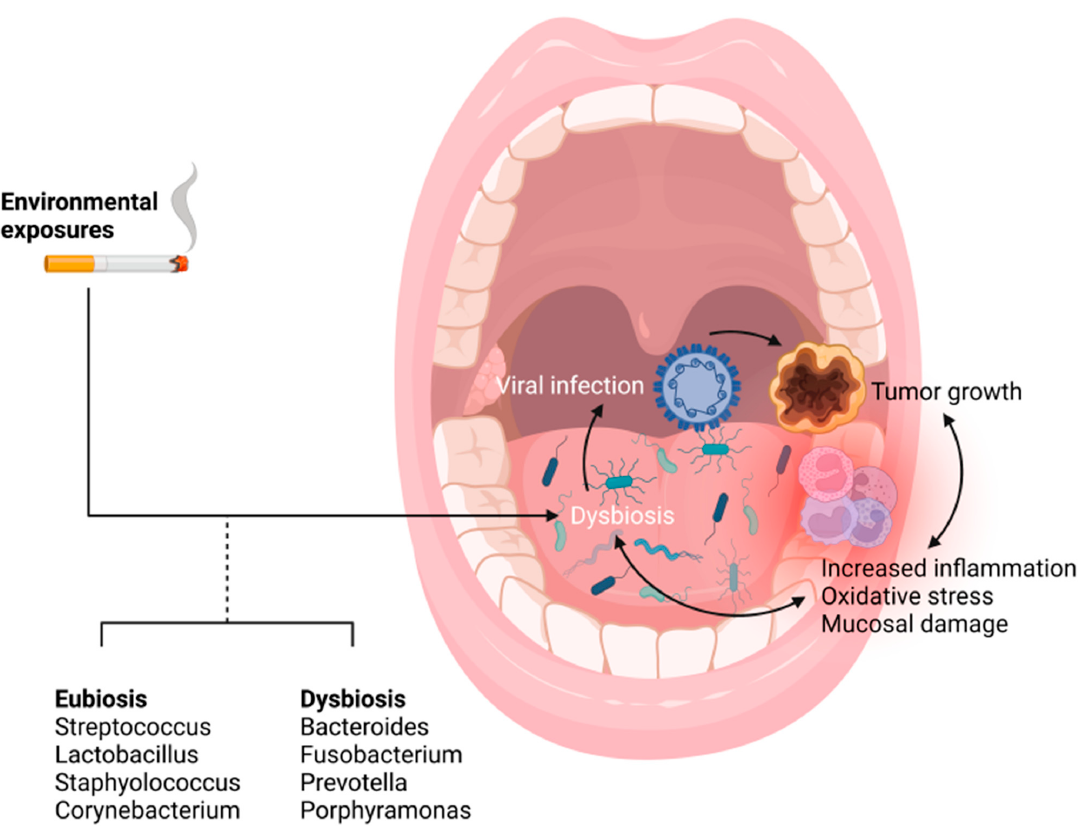
Figure 1. Overview of environment-host-microbiome-tumor interactions. Schematic overview of the interplay between the environment, the oral microbiome, human papillomavirus (HPV), a tonsillar tumor, and host inflammation. Environmental factors, such as tobacco smoke, alter the oral microbiome [7,25–29]. Meanwhile, bacterial shifts in the oral microbiome modulate viral proliferation and infection [30]. The interplay of these microbiological factors, a tumor, and the host immune system is complex [31–33]. Figure generated using BioRender.